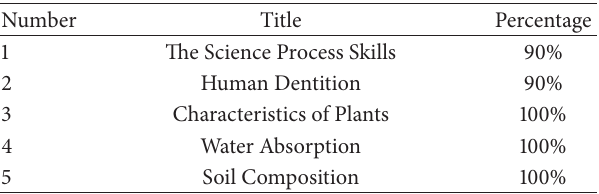
Table 2: The result of interview on students’ learning interest on each